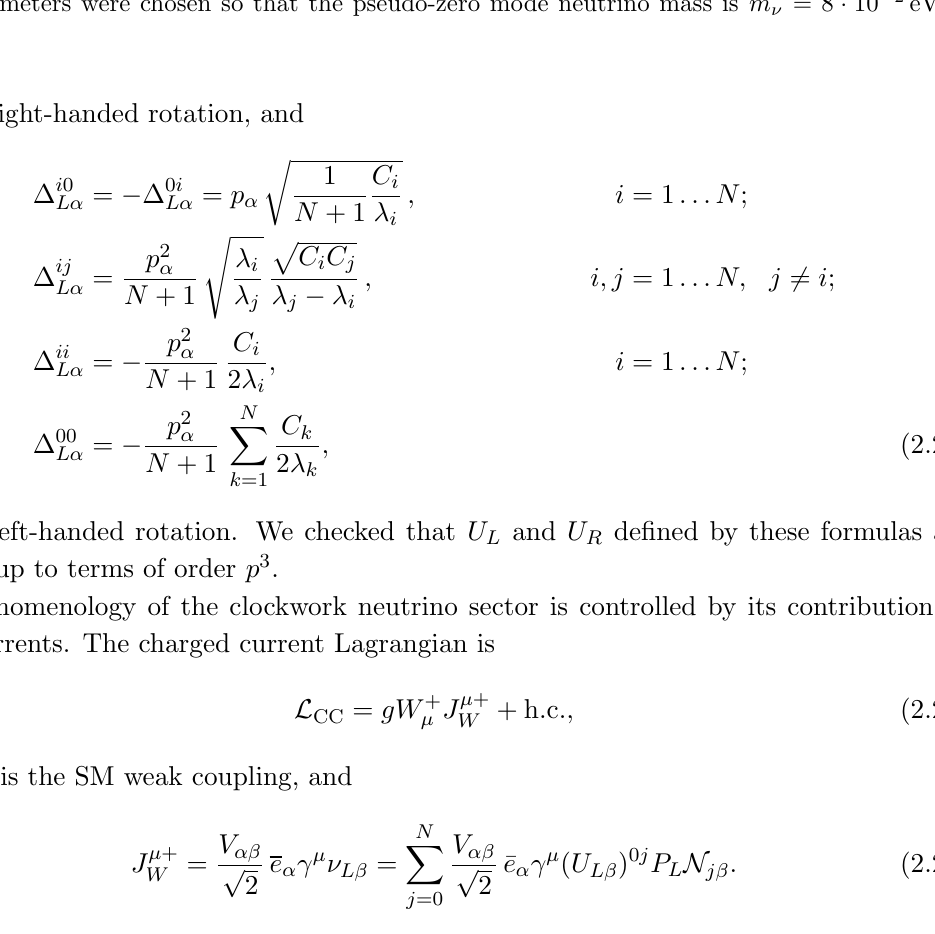
10 (cid:0) 2 eV in (cid:1)